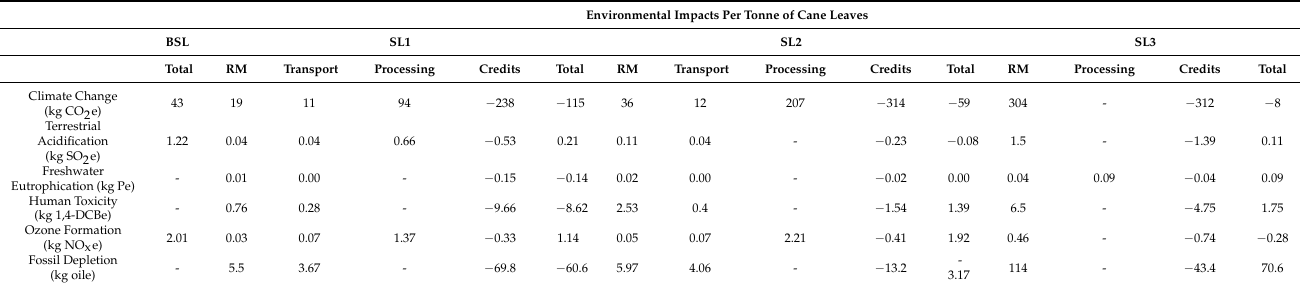
Table 3. Environmental impact potentials classified by the life cycle stages of different cane leaves management scenarios.